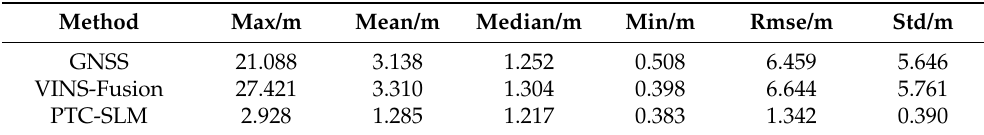
Figure 11. Trajectories of the three methods in rural scene. ( a ) GNSS, ( b ) VINS-Fusion ( c ) PTC-SLM. Table 5. Error parameters of the three methods in rural scene.